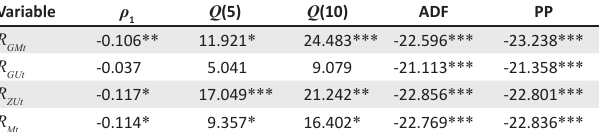
TABLE 2: Serial correlation structure and the stationarity of the variable series, full period (January 2006 to December 2013). Variable